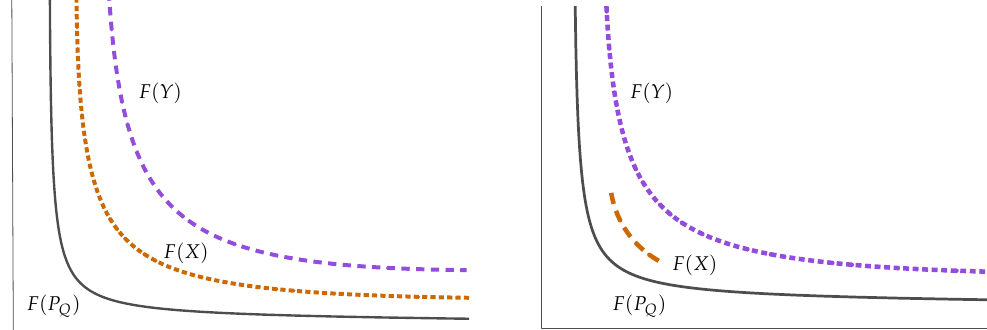
Figure 3. (Left) Example of a Pareto front F ( P Q ) with two archives satisfying condition ( i ) of Theorem 5 for which I GD p , q ( X ) (cid:54) I GD p , q ( Y ) . (Right) Example of a Pareto front F ( P Q ) with two archives satisfying conditions ( a’ ) and ( b’ ) of Remark 3 but for which I GD p , q ( X ) (cid:10) I GD p , q ( Y ) . In this case partitions of the archives satisfying Theorem 5( i ) do not